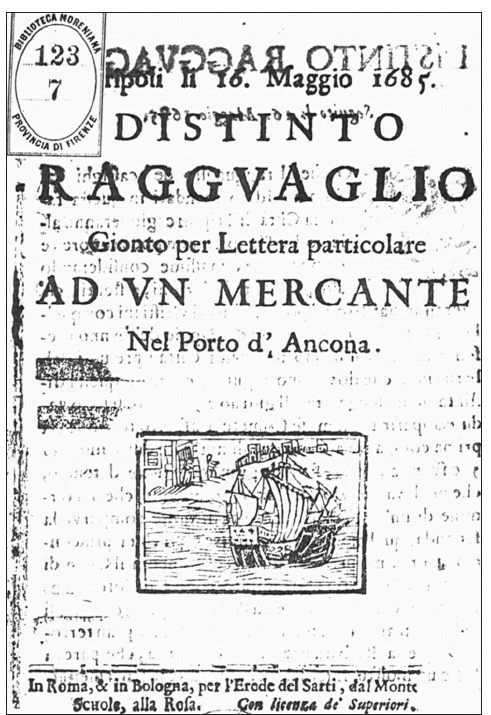
Fig. 2. First page of the flysheet describing the 25 May 1685 eartquake at Tripoli,